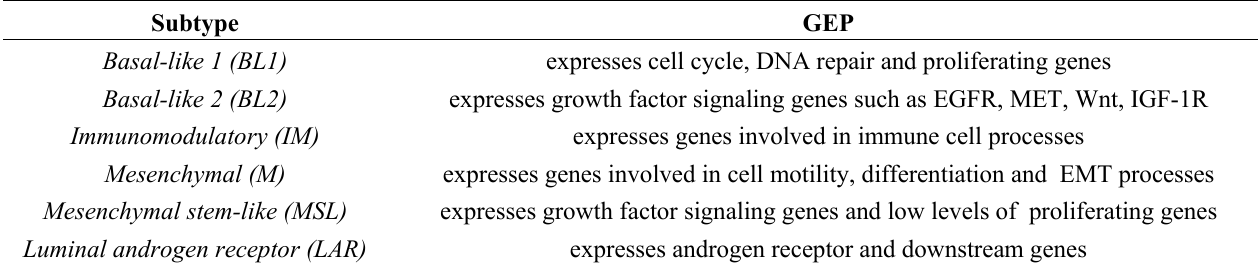
Table 2. Triple negative breast cancer (TNBC) subtypes based on gene-expression profiles (GEP)